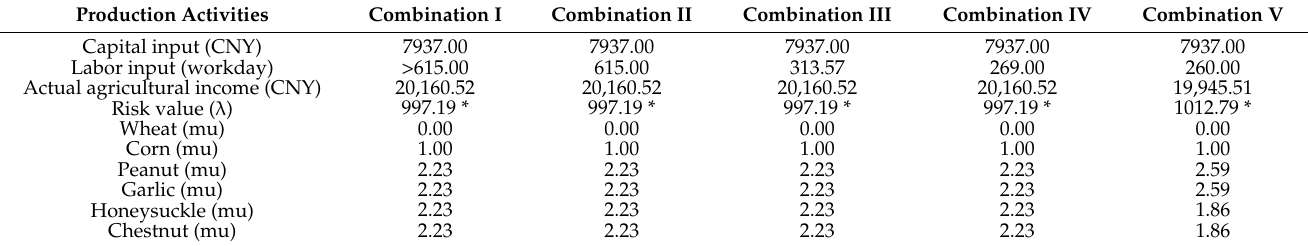
Table 9. Optimization of labor input for I PTPH